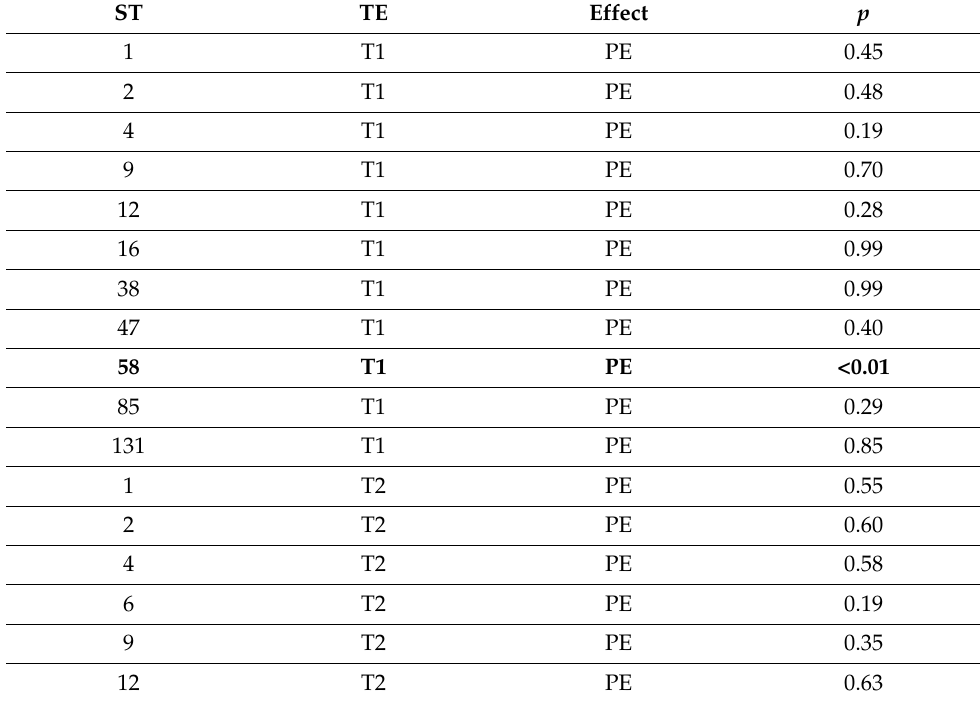
Table 9. Pre-etching treatment effect—one-way